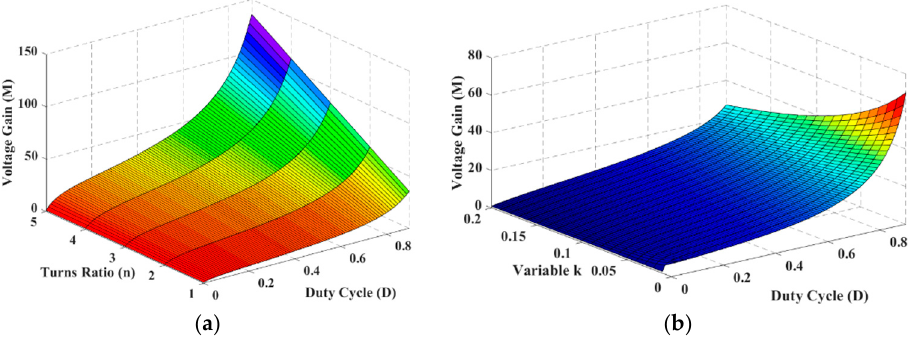
Figure 5. Voltage gain characteristics: ( a ) voltage gain versus different duty cycle and turns-ratio when k = 0.06; and ( b ) voltage gain versus different duty cycle and variable k when n = 1.5.